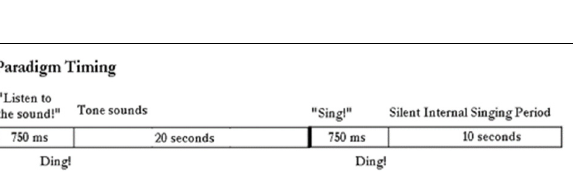
FIGURE 2 | Paradigm timing: The computer outputs “listen to the sound” followed by the tone being emitted from the generator for 20 s. The computer